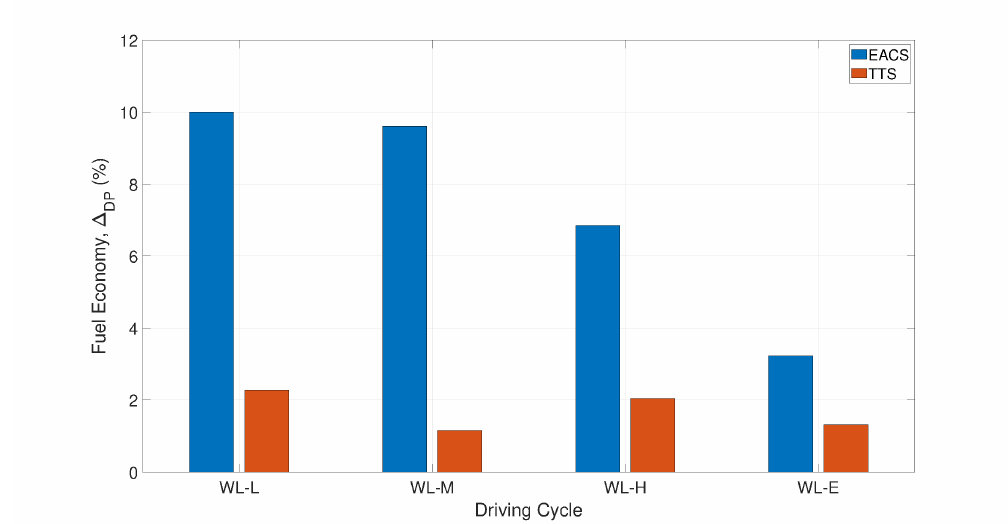
Figure 8. Comparison of fuel economy for the EACS and TTS relative to the performance of the DP, when driving the WL-L, WL-M, WL-H and WL-E